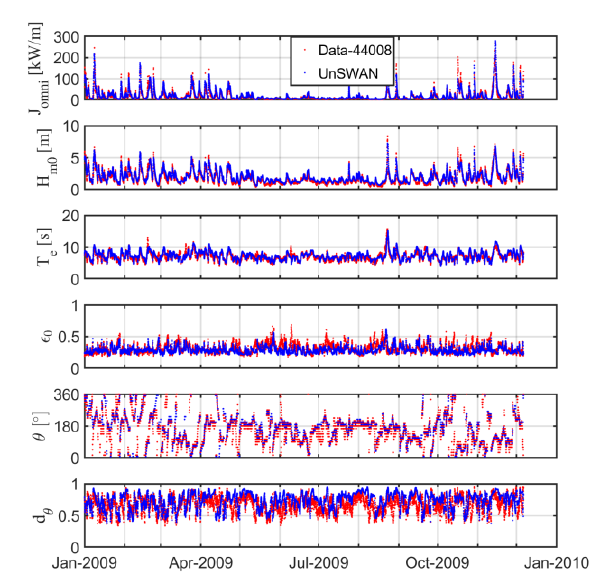
Fig. 8. Comparison of observed and simulated six IEC resource parameters for year 2009 at NDBC buoy 44008 in the East Coast. From top to bottom: omnidirectional wave power, significant wave height, energy period, spectral width, direction of maximum directionally resolved wave power, and directionality coefficient. Buoy location is shown in Fig. 3.